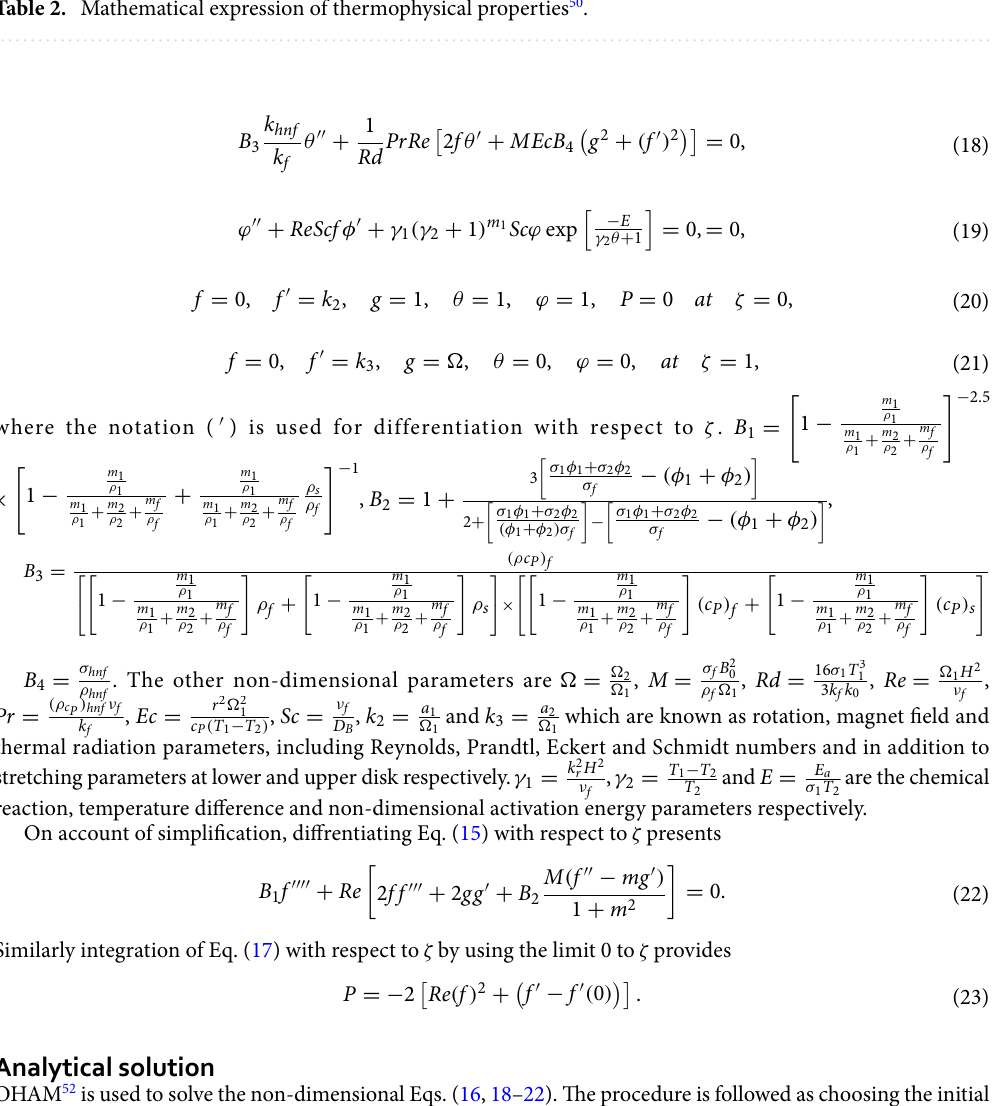
Table 2. Mathematical expression of thermophysical properties 50